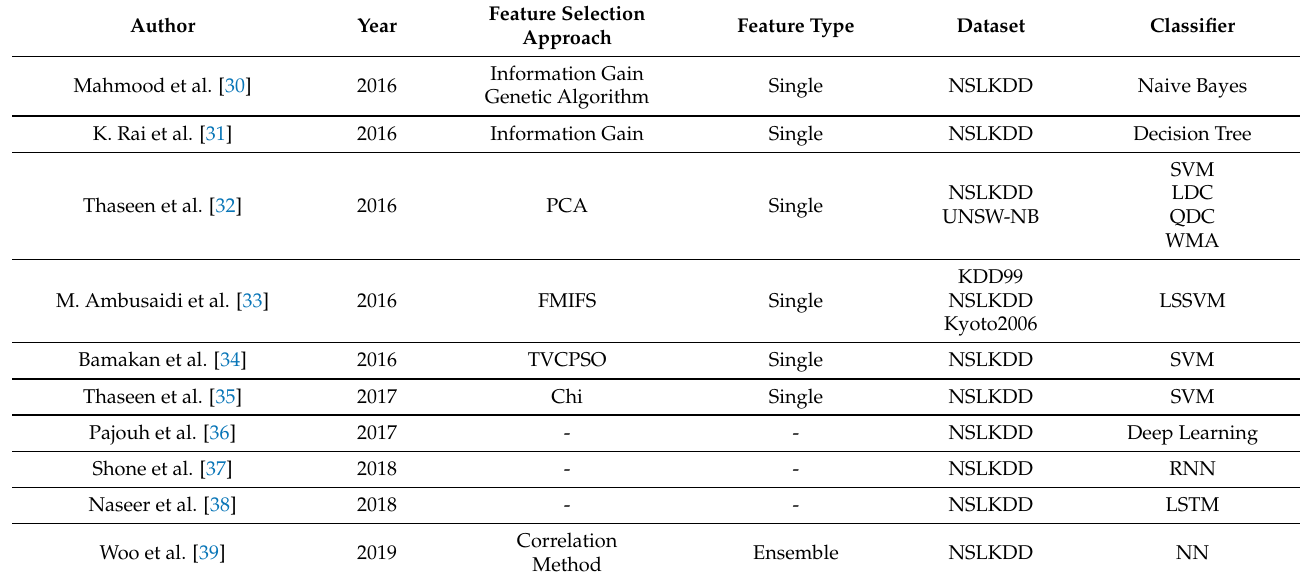
Table 1. Survey on feature selection and classification